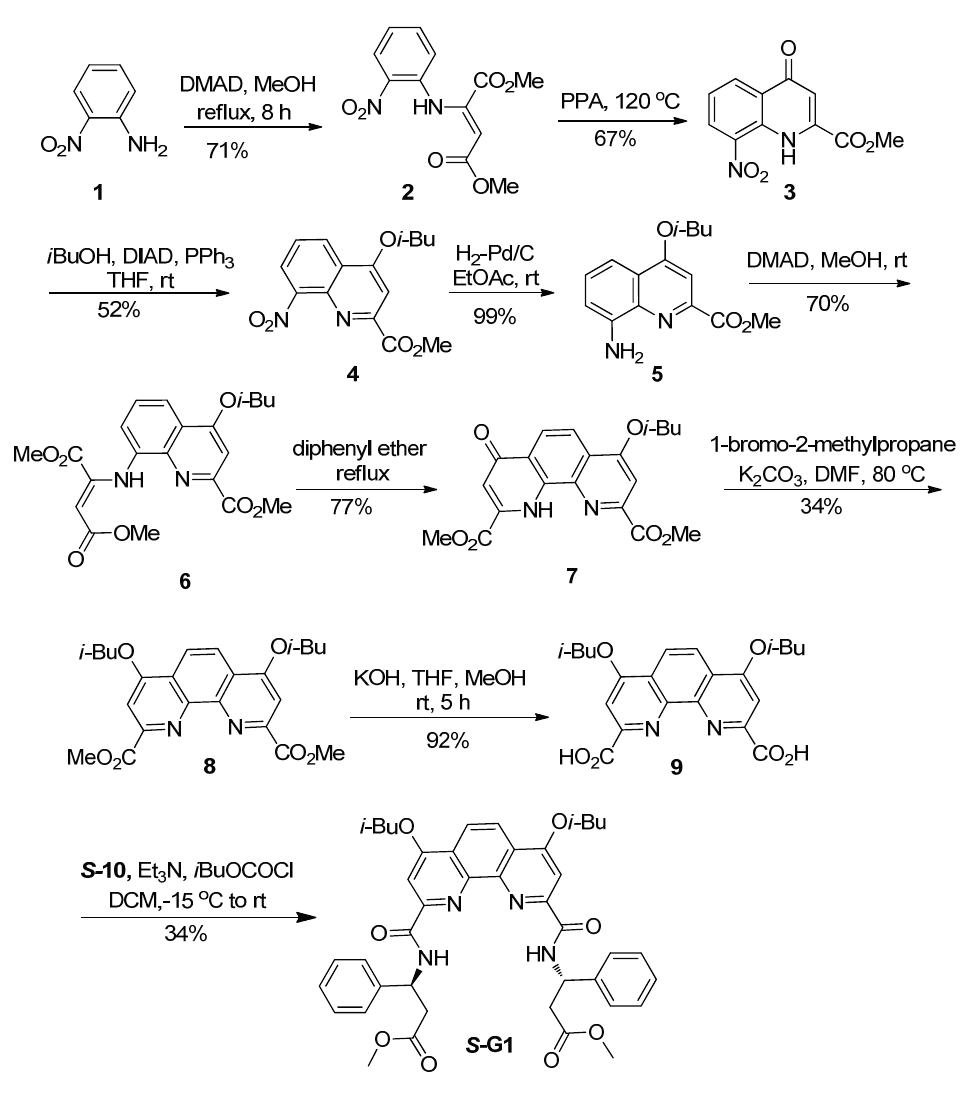
Scheme 2. Synthesis of S -G1